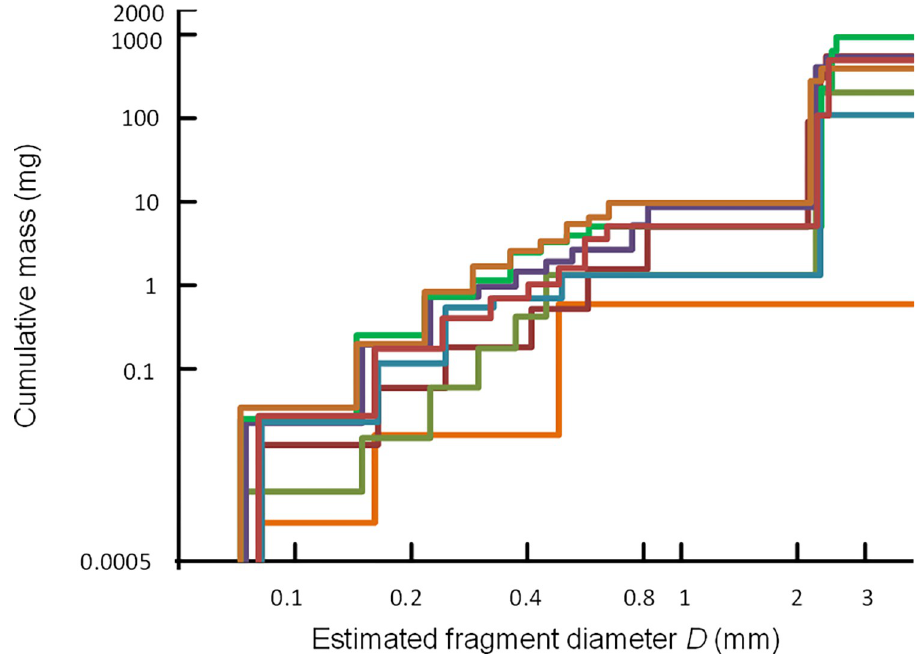
Fig 6. Cumulative mass of ammunition-derived lead in relation to fragment diameter. Cumulative mass (mg), estimated from CT voxel counts, expected to be ingested by consumers eating meat from each of eight pheasants in relation to the consumers’ potential rejection threshold based upon fragment diameter (mm). We assumed that all fragments smaller than the threshold would be ingested by the consumers and all fragments larger than the threshold would be rejected. The result for each of the pheasants we sampled is represented by a coloured line. Both axes are logarithmic but the values shown are not